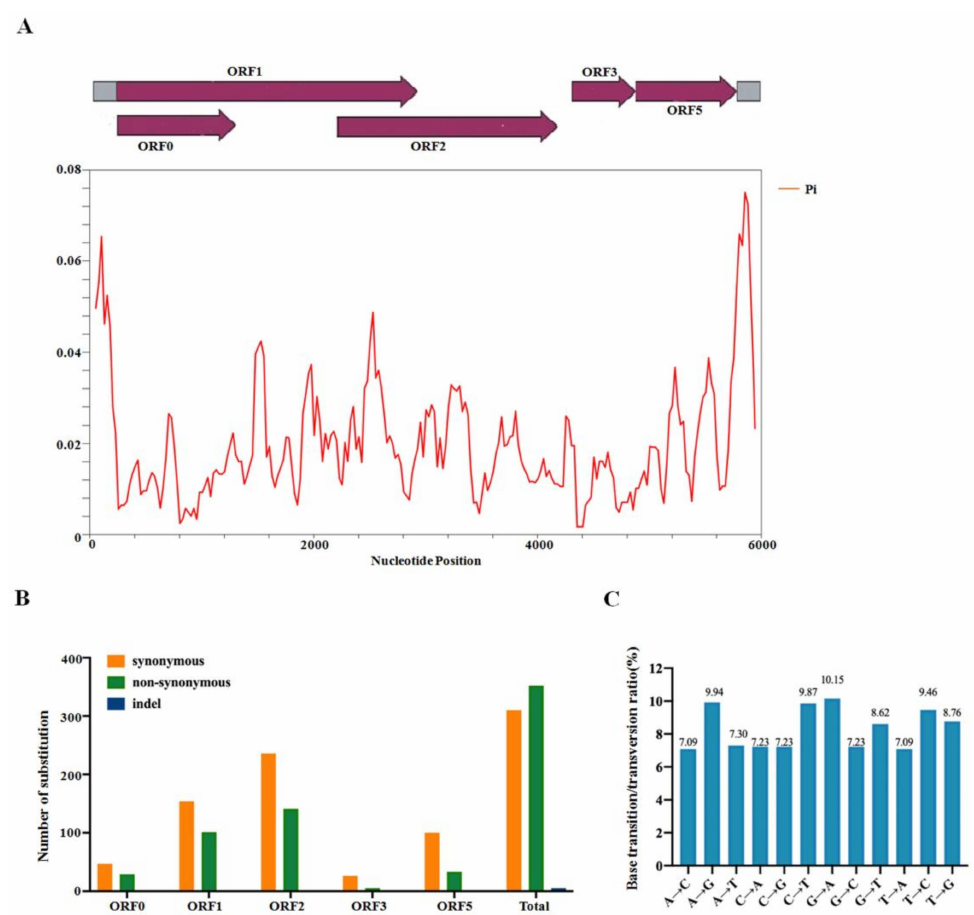
Figure 4. Genome-wide variation in the CVEV genome ( A ) The distribution of genetic variation evaluated along the whole genome of CVEV by nucleotide diversity ( π ). The CVEV genome structure was used as a reference for displaying the variation rate of each ORF region. The window length was 100 nt wide, slide by 25 nt intervals. ( B ) The substitution numbers of five ORFs (indel, non- synonymous and synonymous) in the CVEV genome were shown, respectively. ( C ) The maximum composite likelihood method was used to estimate the base transition and transversion ratio of CVEV